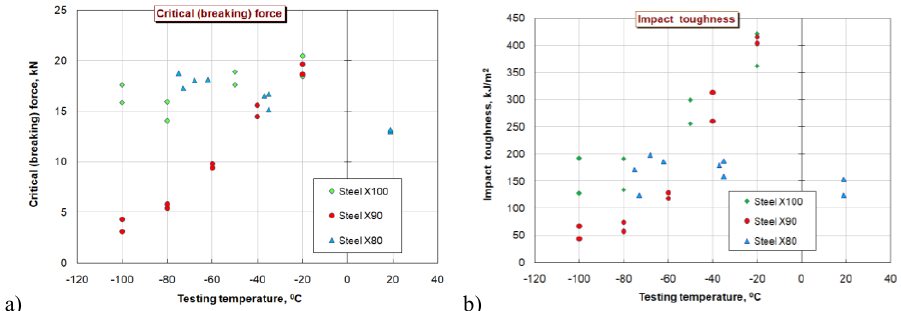
Fig. 5 . Comparison of critical forces (a) and impact toughness (b) in beam specimens with a V-notch at three-point